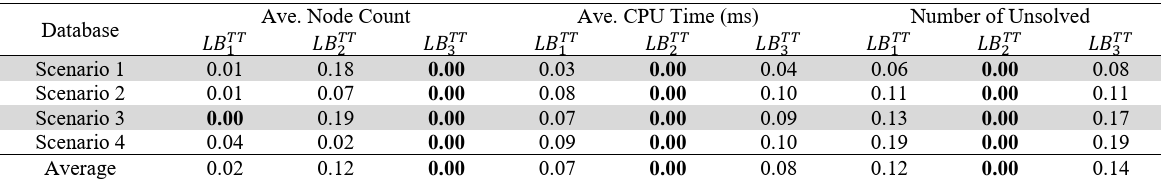
RPD of the variations of the 𝐿𝐵 (cid:3021)(cid:3021) for all